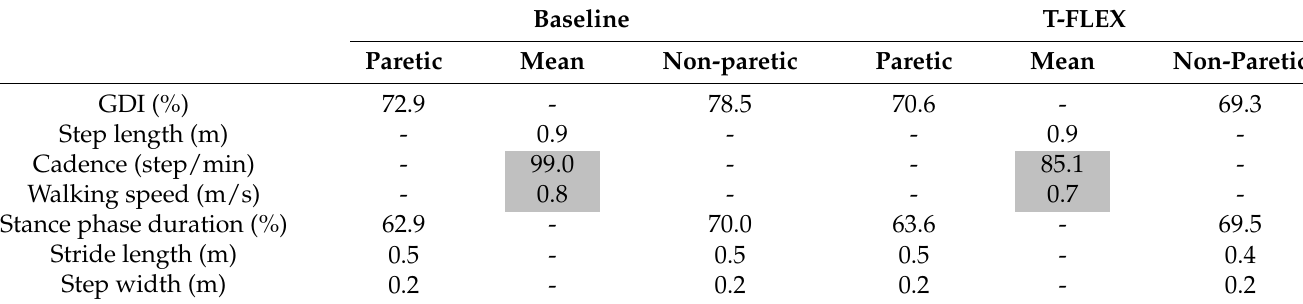
Table 4. Spatial-temporal parameters and Gait Deviation Index of baseline and assisted gait with T-FLEX actuation system. The highlighted values are parameters with significant changes.